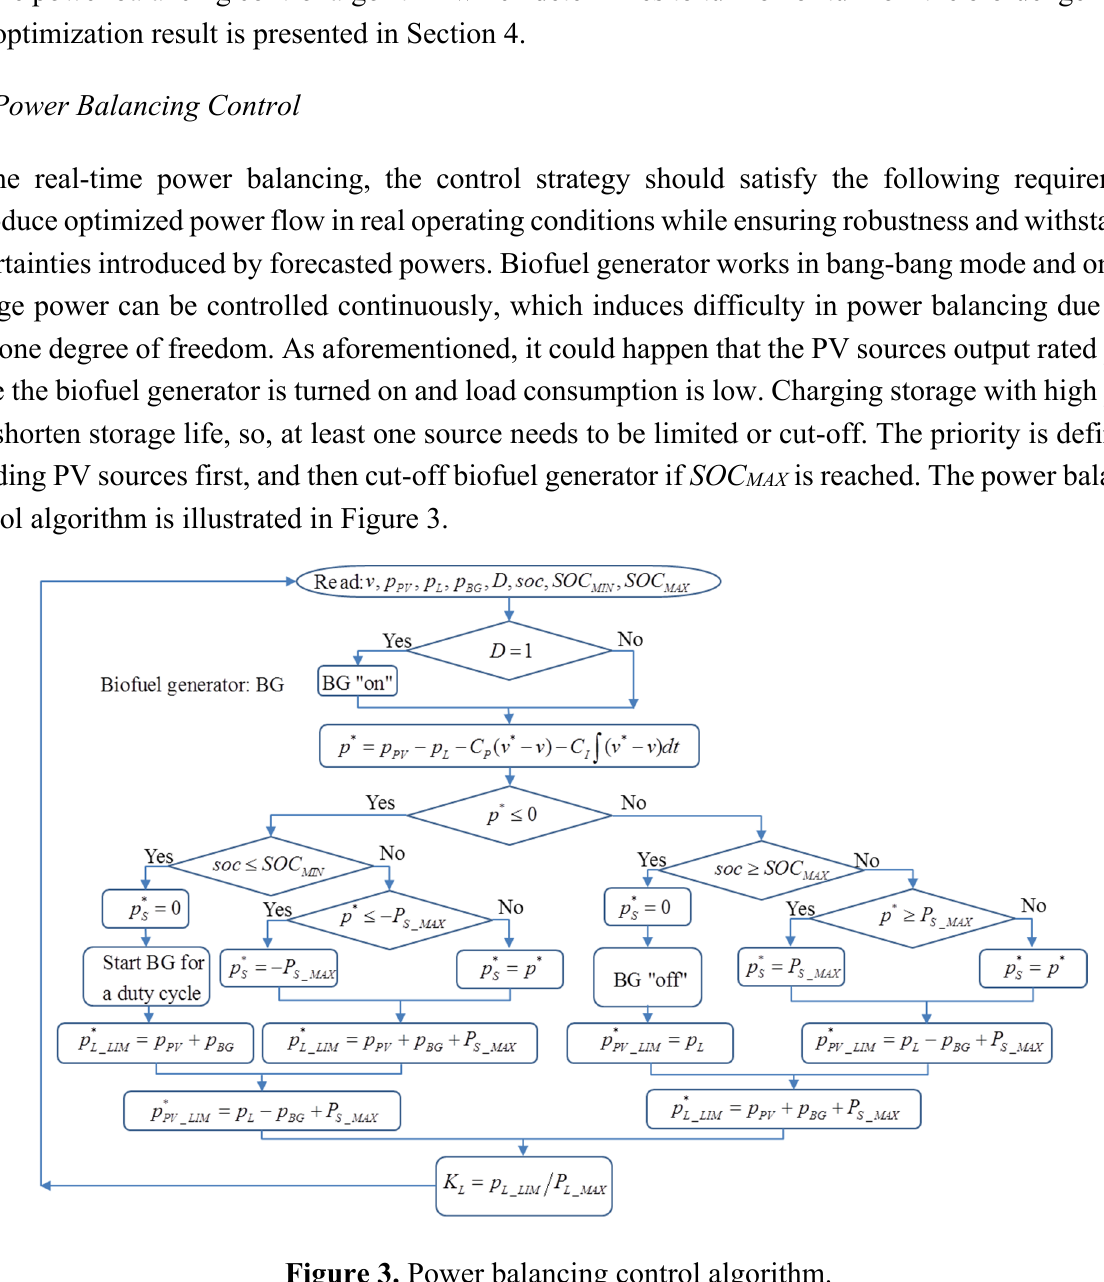
Figure 3. Power balancing control